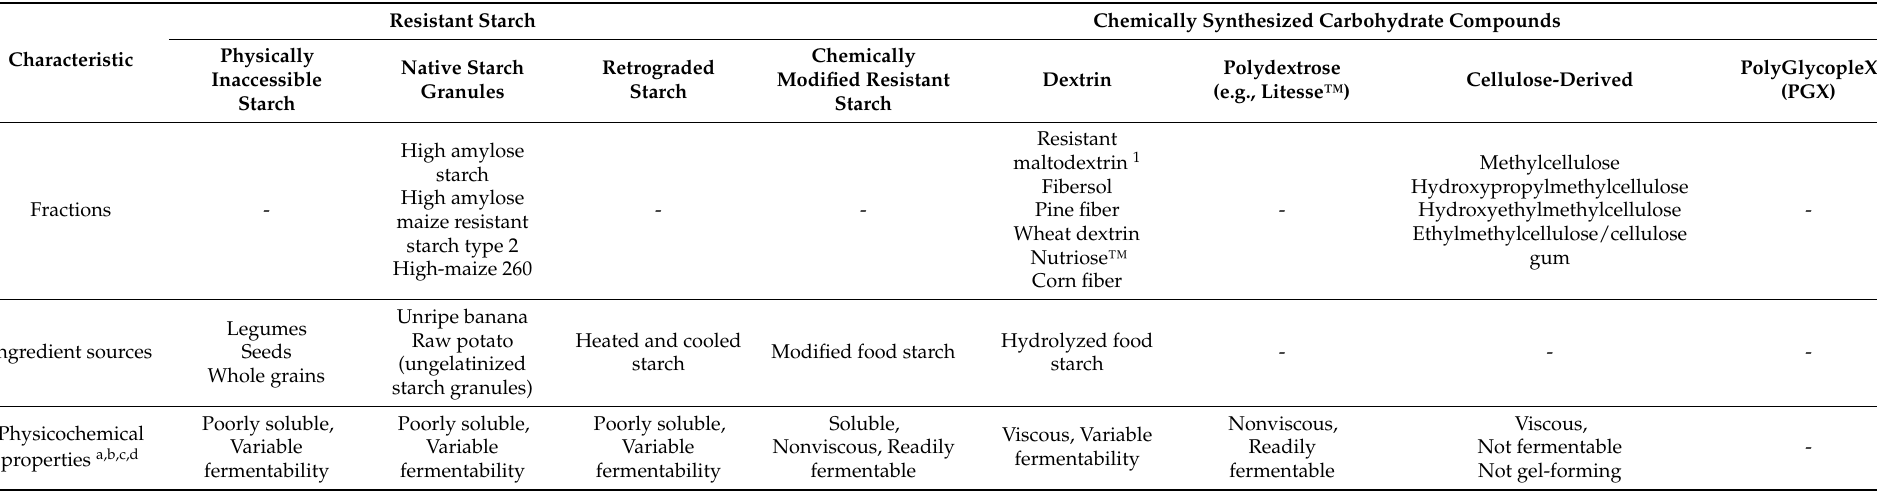
Table 5. Summary of carbohydrate fractions, ingredient sources, and physiological properties of resistant starch and chemically synthesized carbohydrate compounds (adapted from